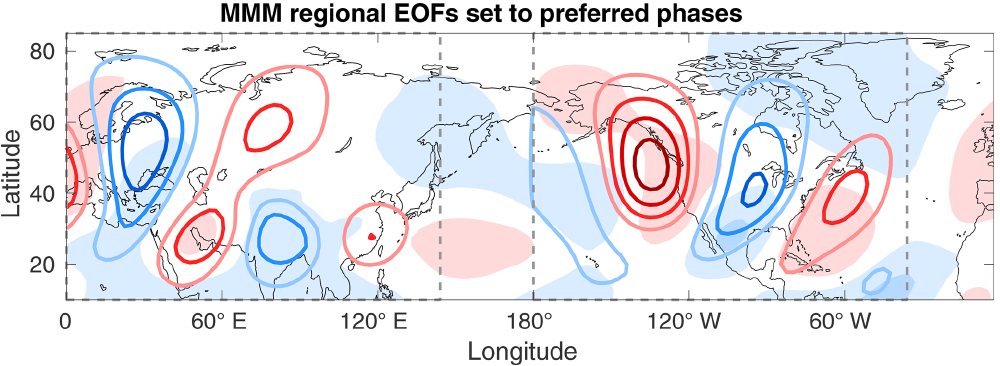
Figure 7. Linear combination of regional EOFs. In contours cos (γ)V EOF1 + sin (γ)V EOF2 . γ is set to represent each group’s approximate preferred phasing ( − π/ 8 for NA; 3 π/ 4 for AS). The contour interval is 1ms − 1 . Light shading is the MMM future–past V trend, and dashed lines define the domains of the regional